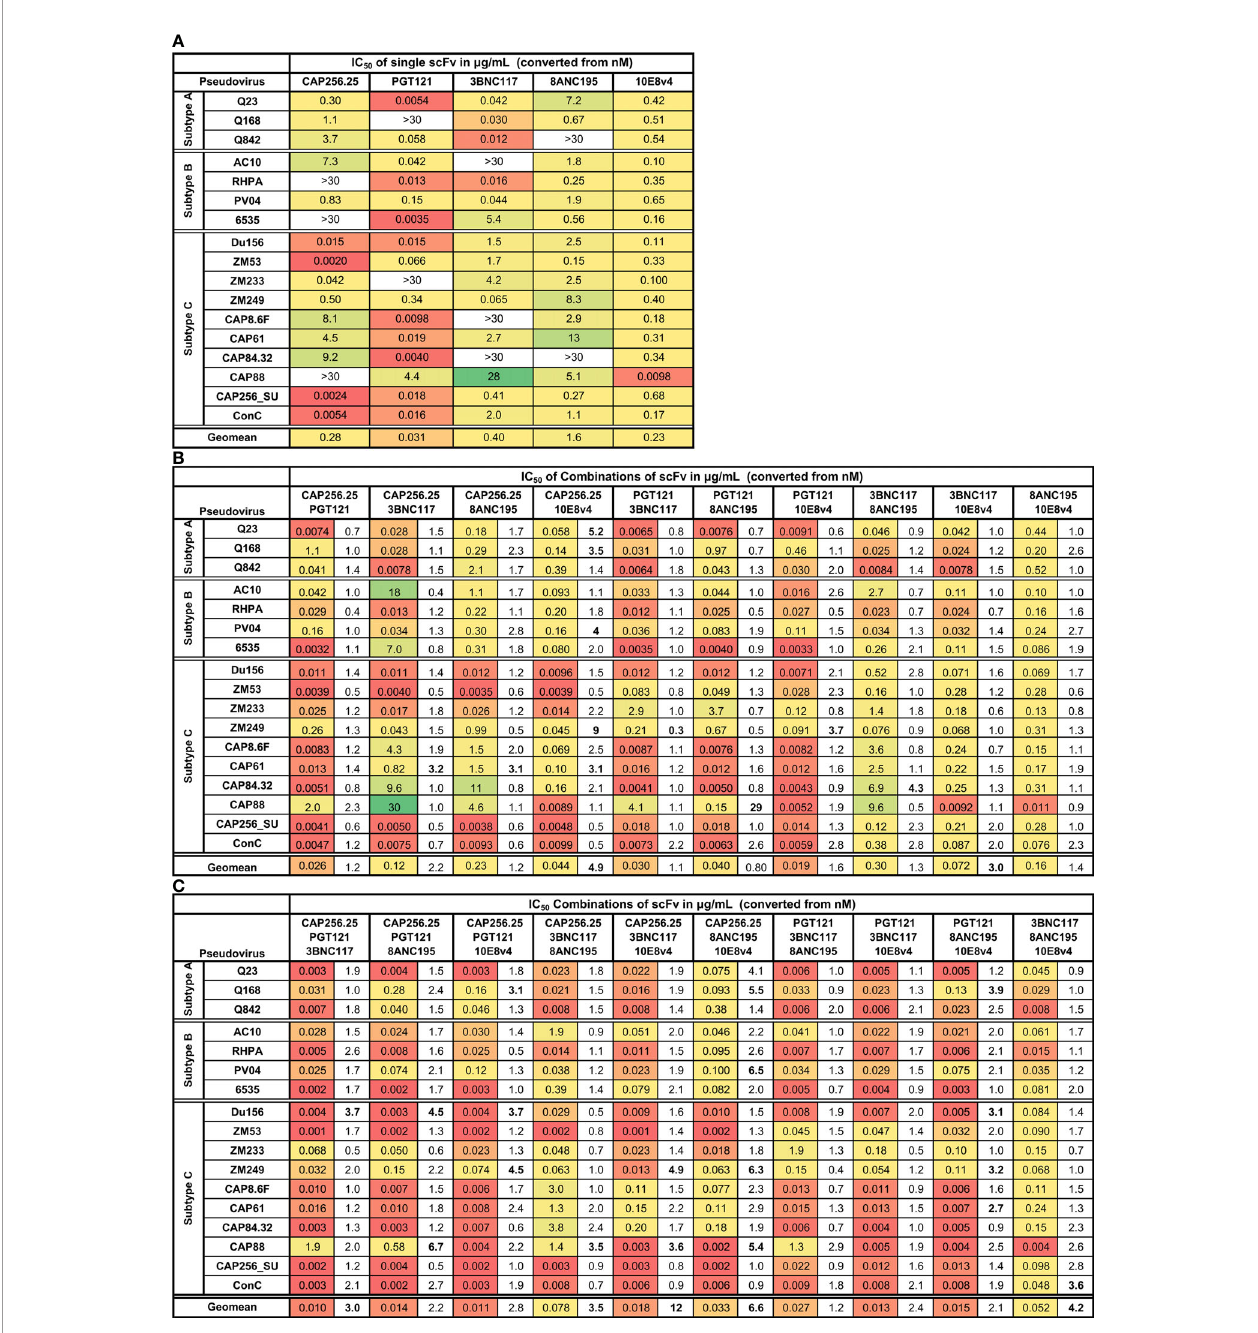
FIGURE 1 | Neutralization titers of single, dual, and triple combinations of scFv. Heat map showing IC 50 neutralization titers in m g/mL for single (A) , dual (B) , and triple (C) combinations of scFv against a panel of 17 subtype A, B, and C viruses. Viruses insensitive to individual bNAbs are shown as >30 m g/mL. The fold improvement in IC 50 titers of the dual and triple combinations relative to the IC 50 of the best scFv in the combination is included in (B, C) . Values with >3-fold increase or decrease in neutralization are shown in bold. Geometric mean potency is included at the bottom of each table. Each scFv is present in the combination at the titer